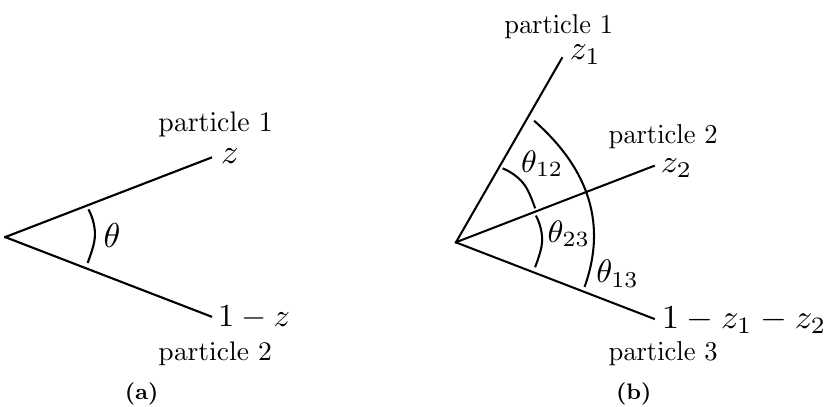
Figure 2. Illustration of the momentum fraction and pairwise angle variables that describe 2-body (right) and 3-body (left) phase